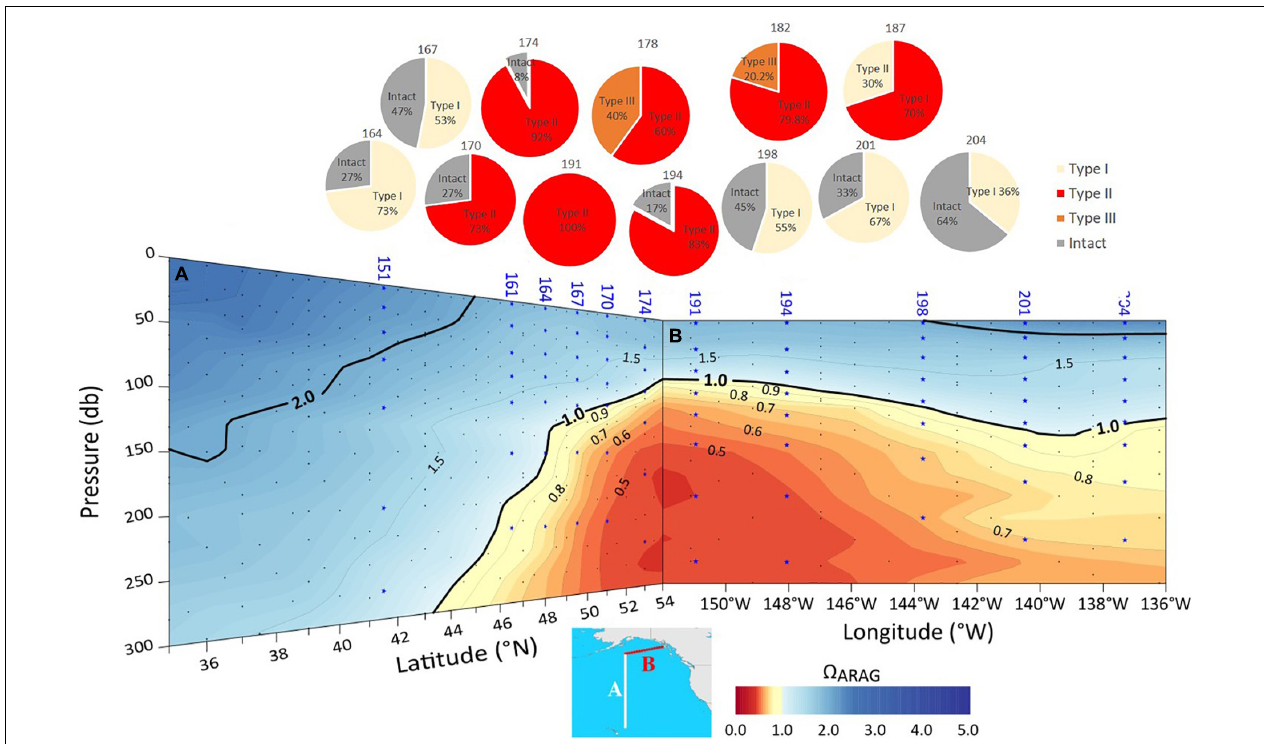
FIGURE 11 | The depth of the aragonite saturation state ( (cid:127) ar ; based on observational data) along two sections conducted on P16N cruise in the Eastern P16N cruise in the Eastern Pacific subpolar gyre (A) and GoA (B) . with corresponding proportions of different types of pteropod shell dissolution. Pteropod samples were analyzed from stations 164 to